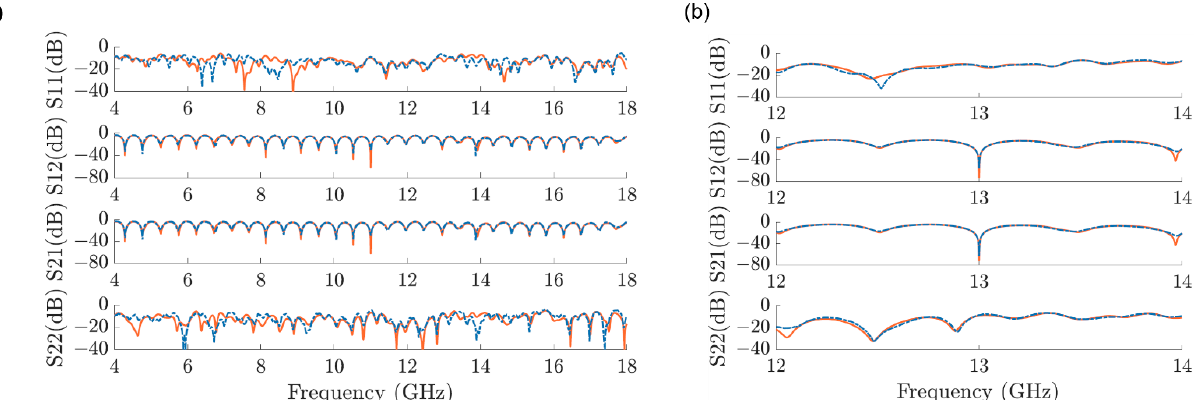
Figure 5. The S − parameter comparisons between the modeled system in ADS with measurement results for ( a ) the whole frequency range of 4 − 18 GHz, tuned at 11 GHz, in the frequency step of 5 MHz; and ( b ) the frequency range of 12 − 14 GHz, tuned at 13 GHz, in the frequency step of 50 kHz. For the sensor simulation, a small sensing CPW section of the length T equals 10 µ m has been modeled in CST (Figure 6). To obtain fast and accurate simulation results of the particle passing through the sensing CPW, the cubic particle with a side length R = 3 µ m is used in the model. The simulations are carried out for the particle at different positions relative to the cross-section of the sensing CPW at a center height of 2.5 µ m above the substrate. The simulation results depicted in Figure 7 are the magnitude and the phase of transmission signal S 21 . The blue solid line and the orange ribbons around it are simulation results and their error range, respectively. While the yellow solid line and blue ribbon around it are respectively the mirrored simulation results and their error range of the left half to demonstrate their symmetry with the right half of the simulation results. The particle introduces signal variations when it passes through the region with high electromagnetic (EM) fields. As well, in correspondence with the EM field intensity, which is highest at the two gaps and relatively low at the center of the signal line, the variation signal caused by the particle shows a profile of “M” shape for both the magnitude and phase of S 21